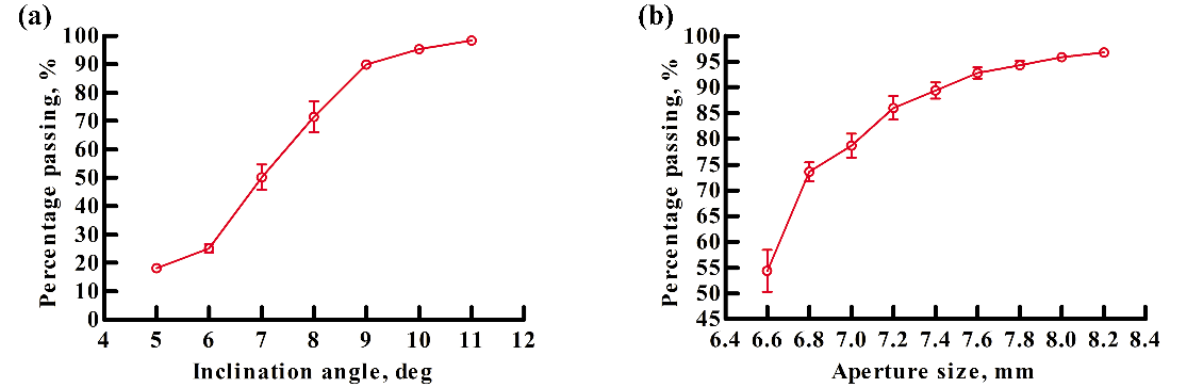
Figure 7. For the soybean particle of J-17: ( a ) The relation between the percentage passing and the inclination angle, ( b ) the relation between the percentage passing and the aperture size.